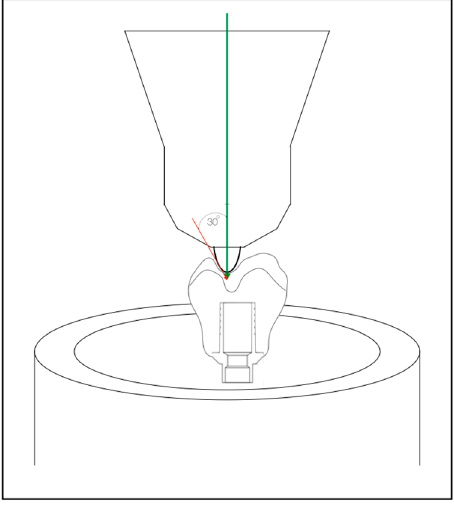
Figure 2. Dynamic loading of upper molar with masticatory simulator (CS ‐ 4,SD Mechatronik, Westerham, Germany) for fatigue testing. Embedded implant with crown in standard sample pot. Steel cone antagonist adjusted to touch the crown at the fissure.